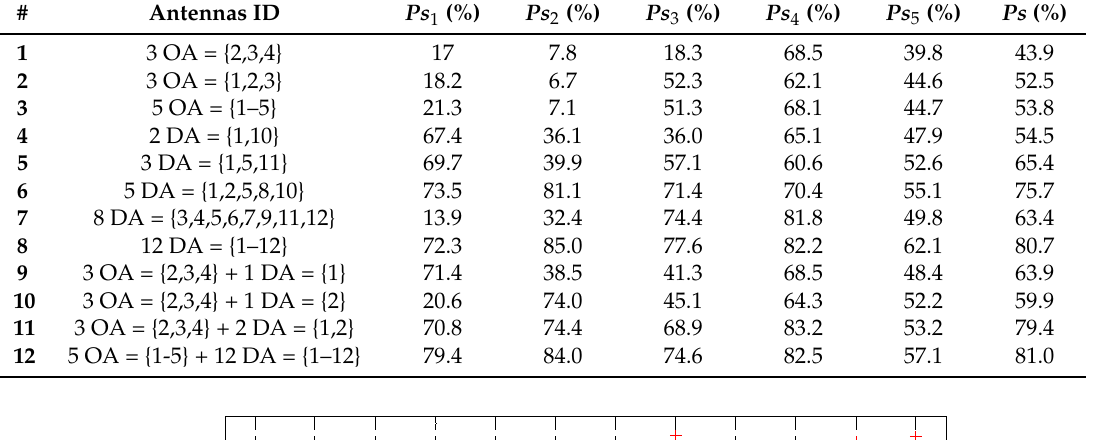
Table 2. Success probability per room P Sr ( r -th room) and overall P S .